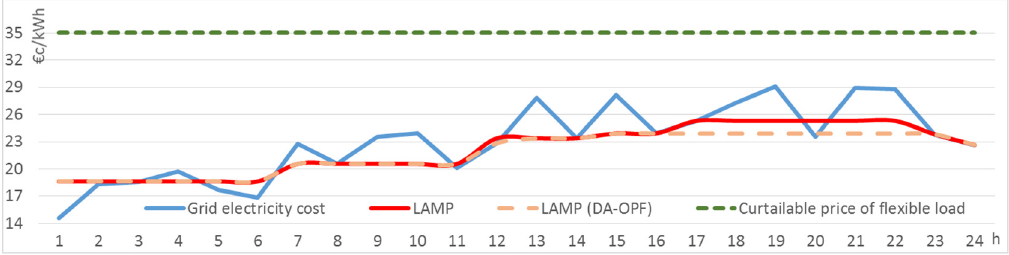
Figure 11. Grid electricity price, LAMP, and the curtailable price of flexible load (summer case).